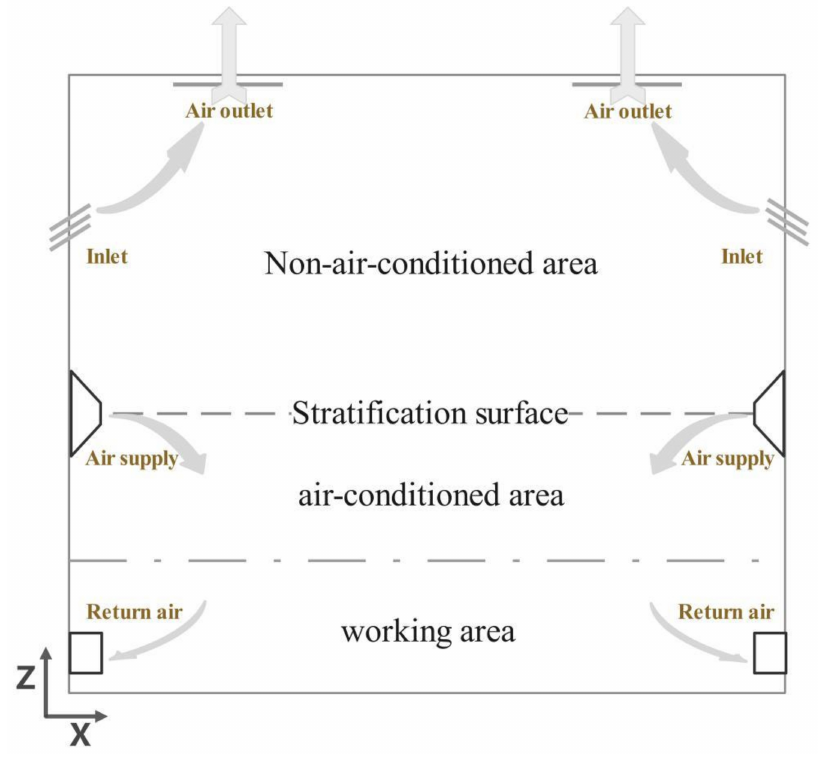
Figure 1. Schematic diagram of airflow organization of stratified air